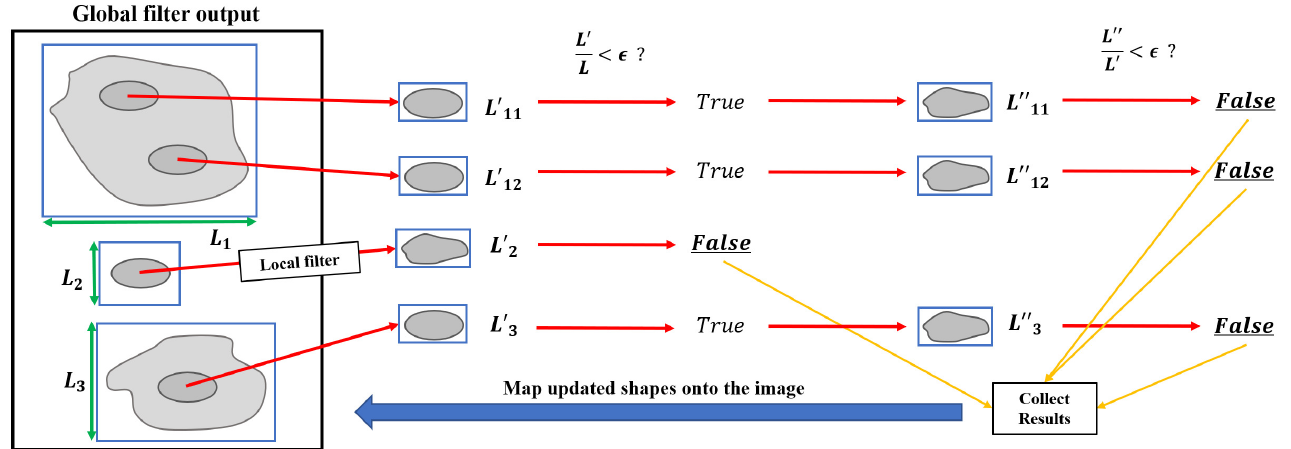
Figure 4. A schematic illustration for the MRIF algorithm. The gray domains represent detected